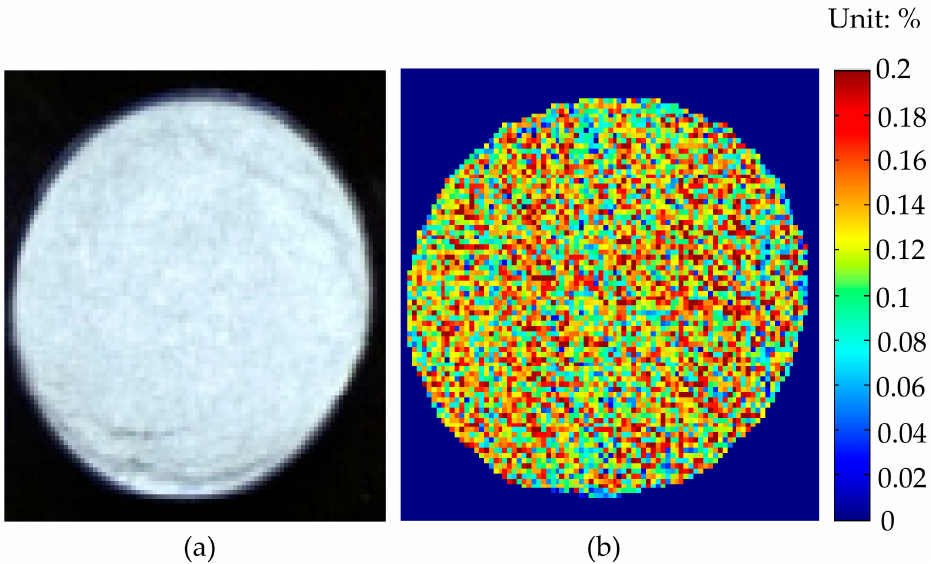
Figure 7. ( a ) The hyperspectral image and ( b ) the corresponding TN content distribution map visualized based on the UVE–ELM